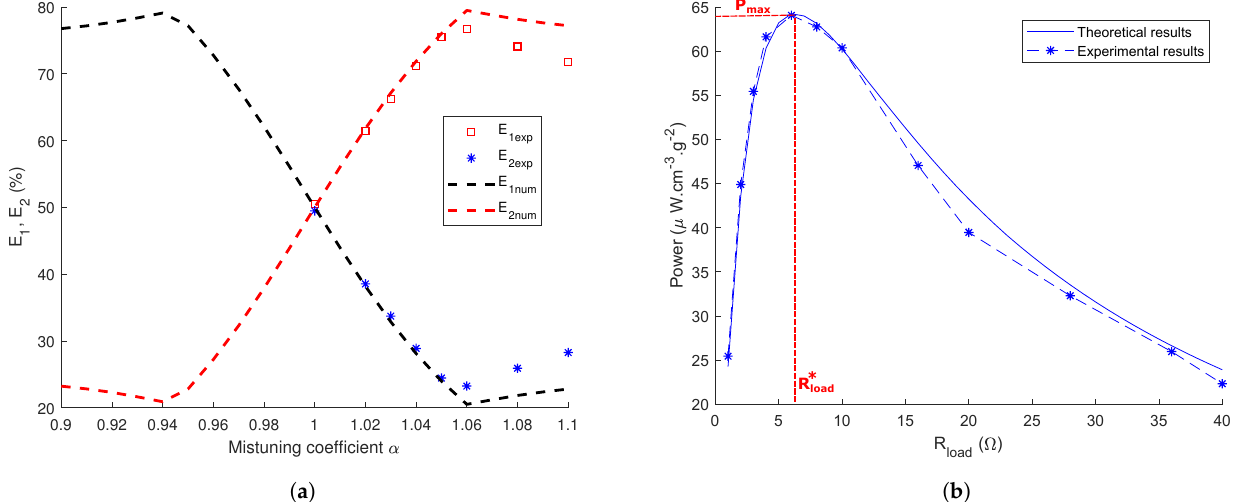
Figure 3. ( a ) Numerical and experimental energies of the 1st and 2nd DOFs versus mass mistuning coefficient ( a rms = 1 g, R load = 6 Ω ). ( b ) Harvested power from the perturbed magnet with load resistance ( a rms = 1 g, α =